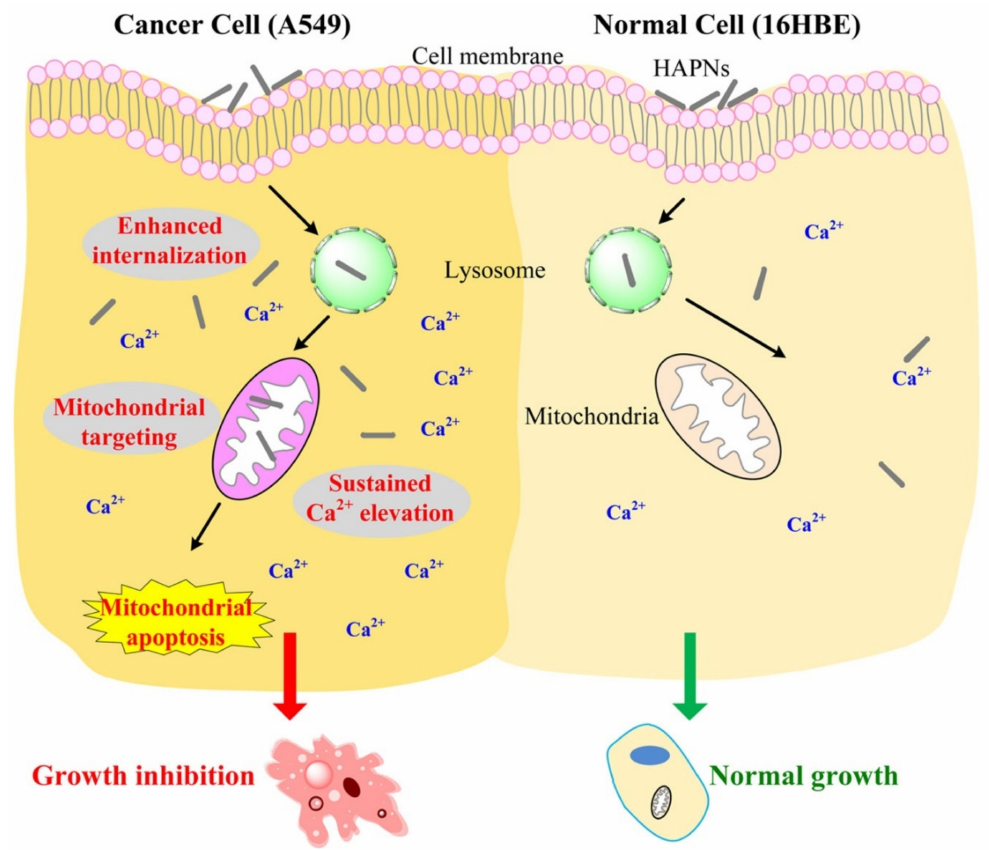
Figure 4. HAp-induced mitochondria-mediated apoptosis. Internalization of HAp NPs in A549 cells is represented. The intracellular Ca 2+ overload can induce mitochondria damage and activation of apoptotic mechanisms. It is proposed that normal cells, as the bronchial epithelial cell line 16HBE depicted in this figure, can restore the homeostasis of this cation. Figure republished from [33] with permission from the American Chemical Society. Copyright ©